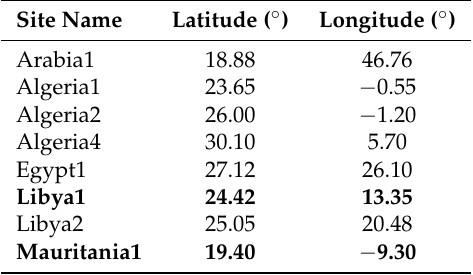
Table 3. PICS used in this study (Boldfaced are two sites recommended by CEOS